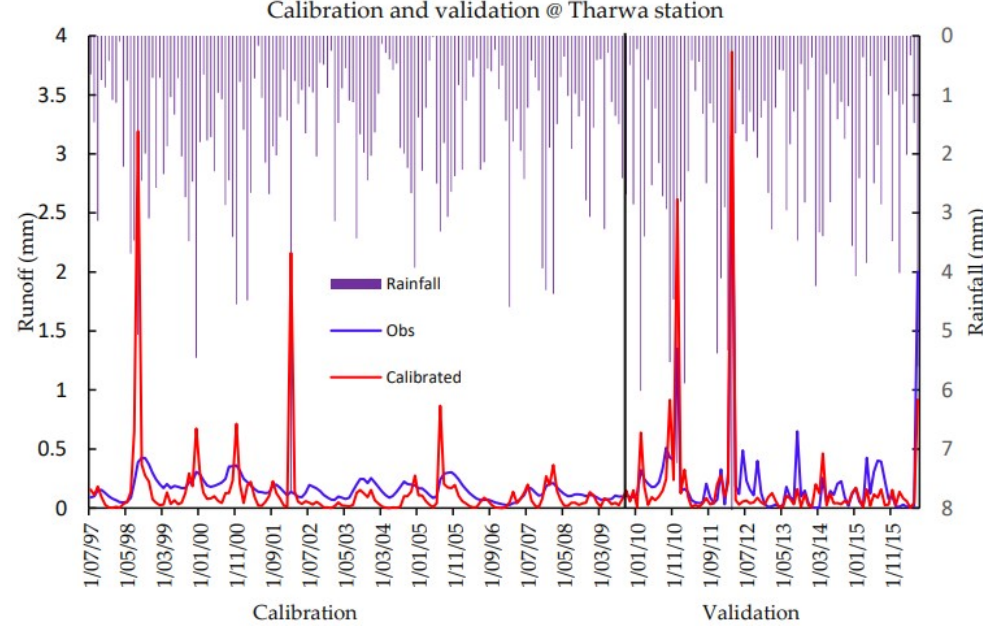
Figure 6. A comparison between observed and SIMHYD modeled runoff during calibration and validation period at Tharwa station. 3.2. Spatial and Temporal Variability of Future Rainfall This section presents the results of rainfall analysis done by comparing historical observed rainfall for the period 1985–2016 with projected rainfall under emission scenarios